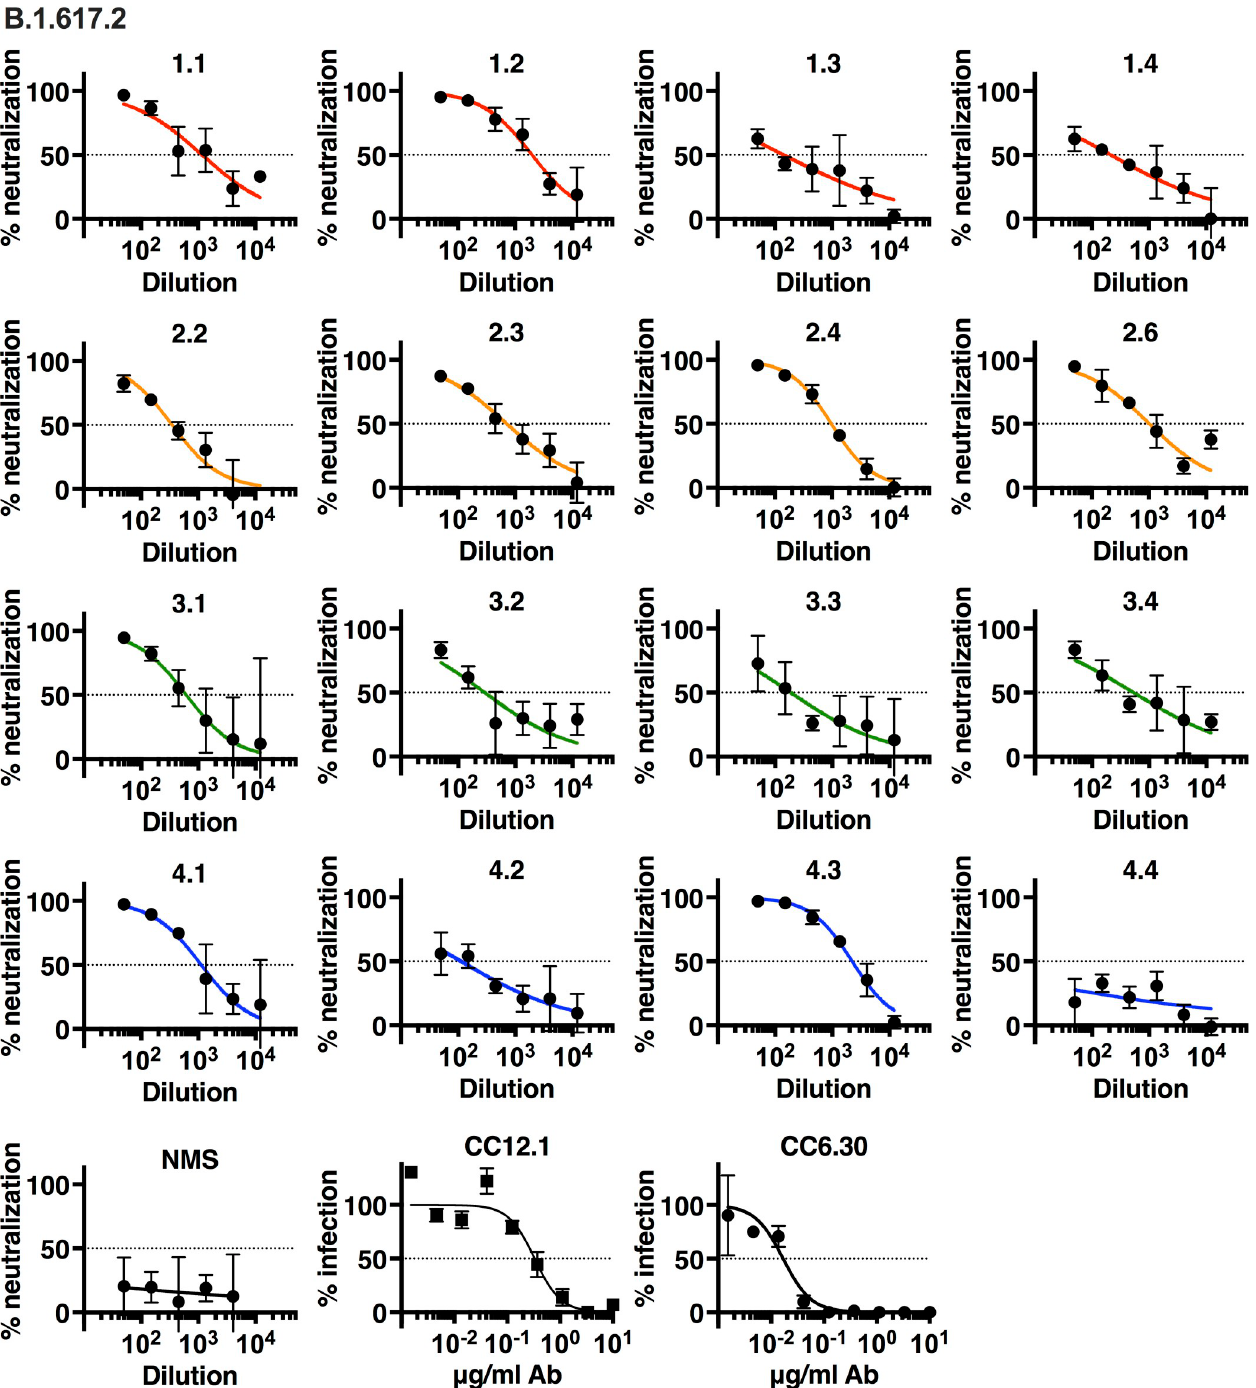
Fig 5. Neutralization of authentic SARS-CoV-2 VOC B.1.617.2/Delta isolate. Neutralization of authentic SARS-CoV-2 isolate B.1.617.2 by immune sera was measured by focus reduction neutralization test (FRNT) on TMPRSS2-Vero cells. 3-fold serial dilutions started at 1:50. Percent neutralization and percent infection are relative to media-only controls. Data shown are the mean and SD of 2–4 biological replicates. Dotted lines mark 50% neutralization. Color scheme: red = group 1; orange = group 2; green = group 3; blue = group 4. NMS = normal mouse serum.